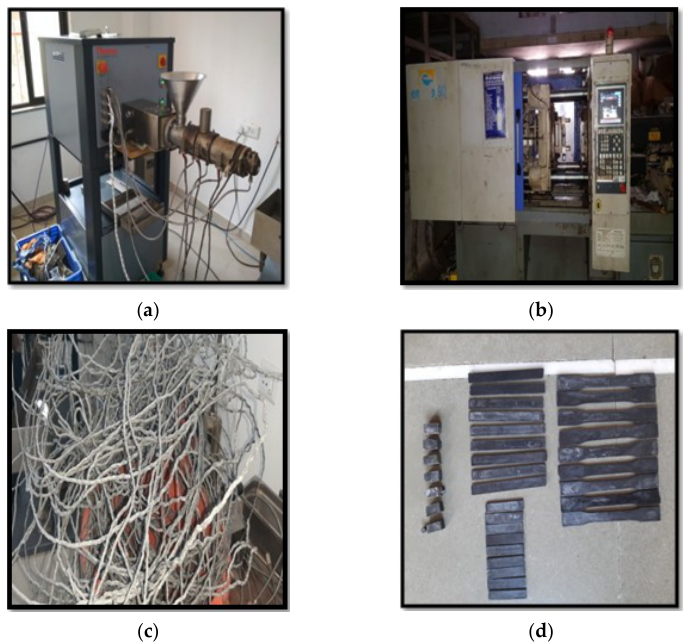
Figure 1. Specimen preparation of pristine MWCNT/PMMA: ( a ) twin screw extruder setup, ( b ) in- jection molding setup, ( c ) filament generation of the prepared nanocomposite, and ( d ) testing spec- imen preparation.